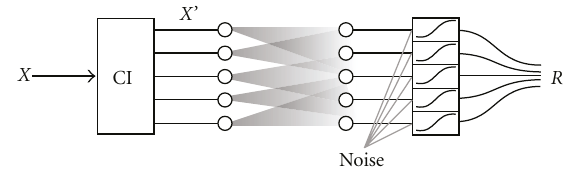
Figure 5: Block diagram of Model B. The CI unit provides a filter bank and sound level to electric current mapping. The current from each channel is spread to the neural groups according to the transfer matrix T . Additive gaussian noise is used to simulate the variability of the neural response.